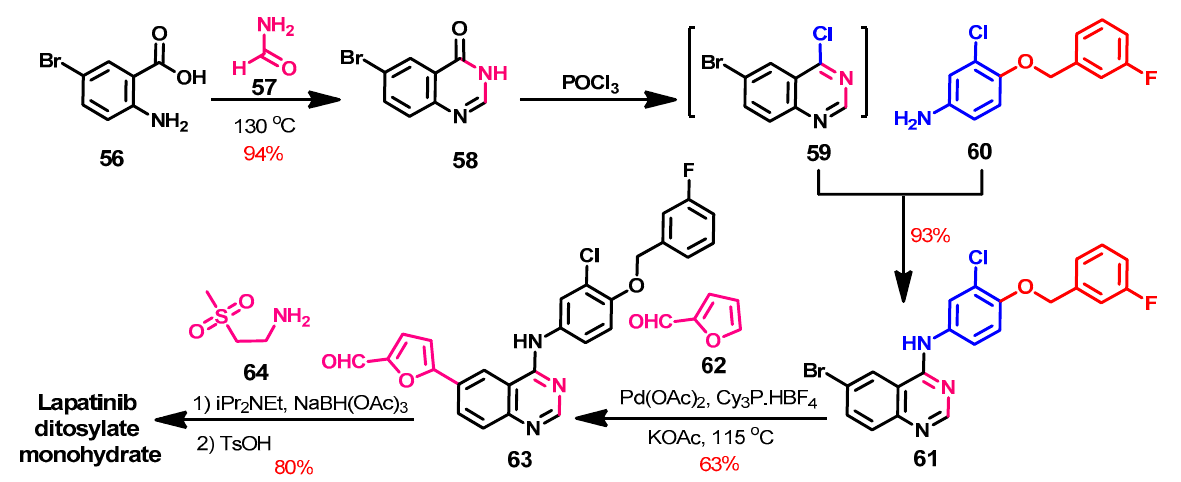
Scheme 8. Synthesis of lapatinib ditosylate monohydrate.